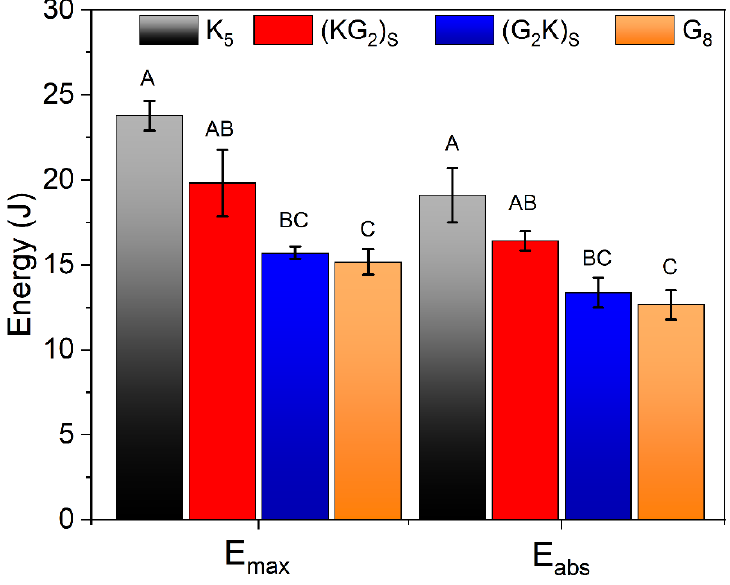
Figure 8. Maximum and absorption energy obtained in the QSI test.